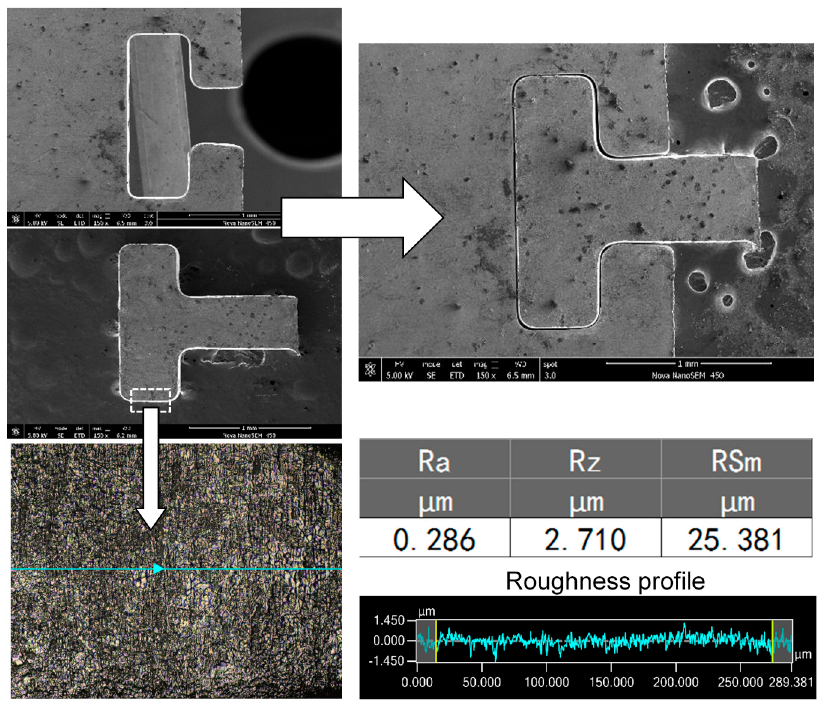
Figure 21. T-type micro connector.